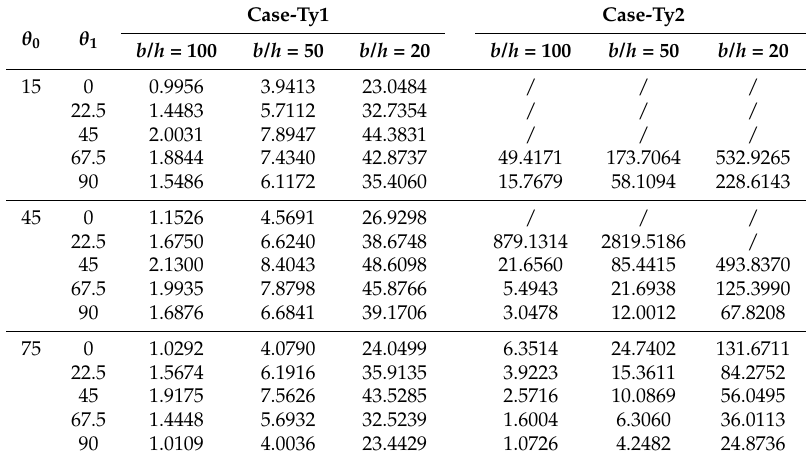
Table 4. Non-dimensional thermal buckling loads T α 22 × 10 3 for [ ± < θ 0 | θ 1 > y ] s laminates subjected to SSSS boundary conditions. Results obtained using ED3 and 14 × 14 trial